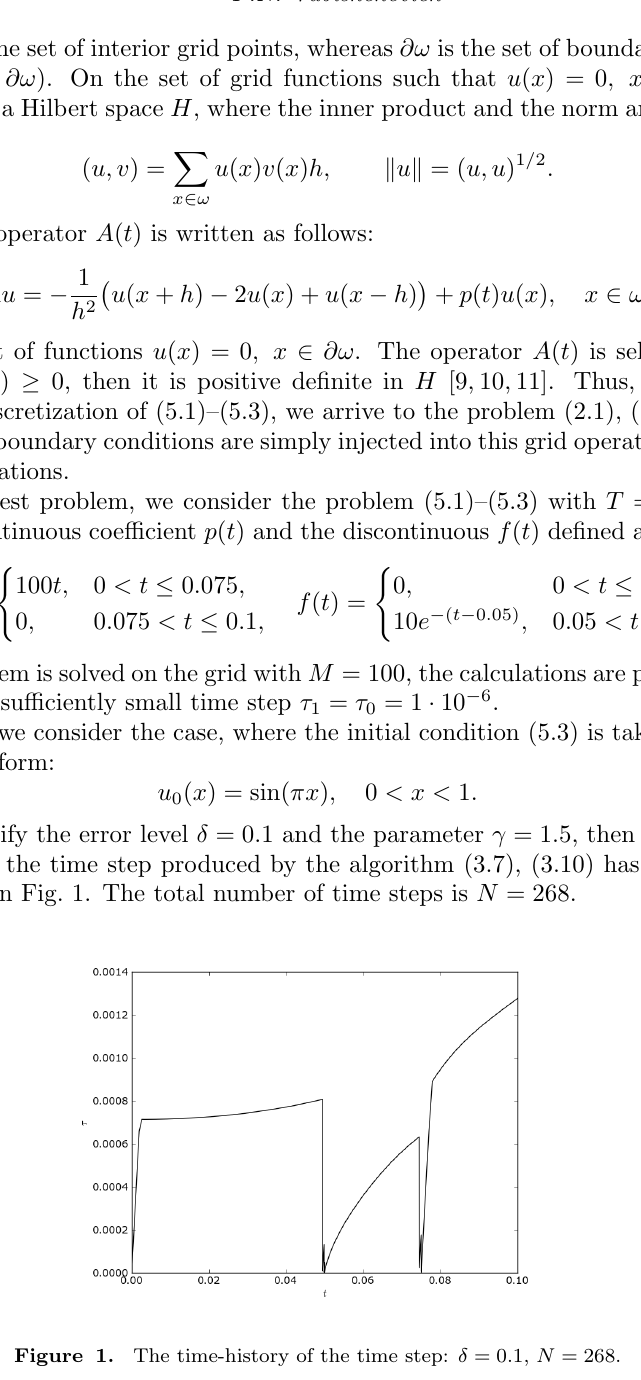
Figure 1. The time-history of the time step: δ = 0 . 1, N =